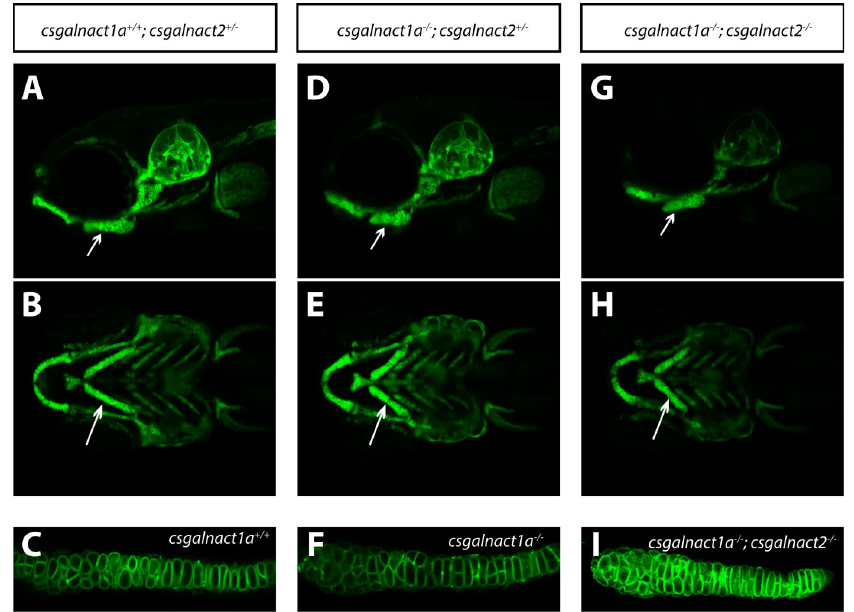
Fig 5. Craniofacial malformations in csgalnact1a -/- and csgalnact1a -/- ; csgalnact2 -/- larvae. LightSheet images of live Tg(col2a1a : mEGFP) larvae at 6 dpf show craniofacial cartilage elements formed in csgalnact1a +/+ ;csgalnact2 +/- (A,B,C), csgalnact1a -/- ; csgalnact2 +/- (D,E,F) and csgalnact1a -/- ;csgalnact2 -/- larvae (G,H,I). Lateral views (A,D,G) display a shorter ceratohyal, ventral views display a wider angle between the ceratohyal elements in csgalnact1a -/- ;csgalnact2 +/- (E) and csgalnact1a -/- ;csgalnact2 -/- (G) larvae (arrow) compared to controls (A,B). A detailed view on the chondorcytes within the ceratohyal (arrow) shows that intercalation occurs even in csgalnact1a -/- (F) and csgalnact1a -/- ;csgalnact2 -/- (I) larvae.